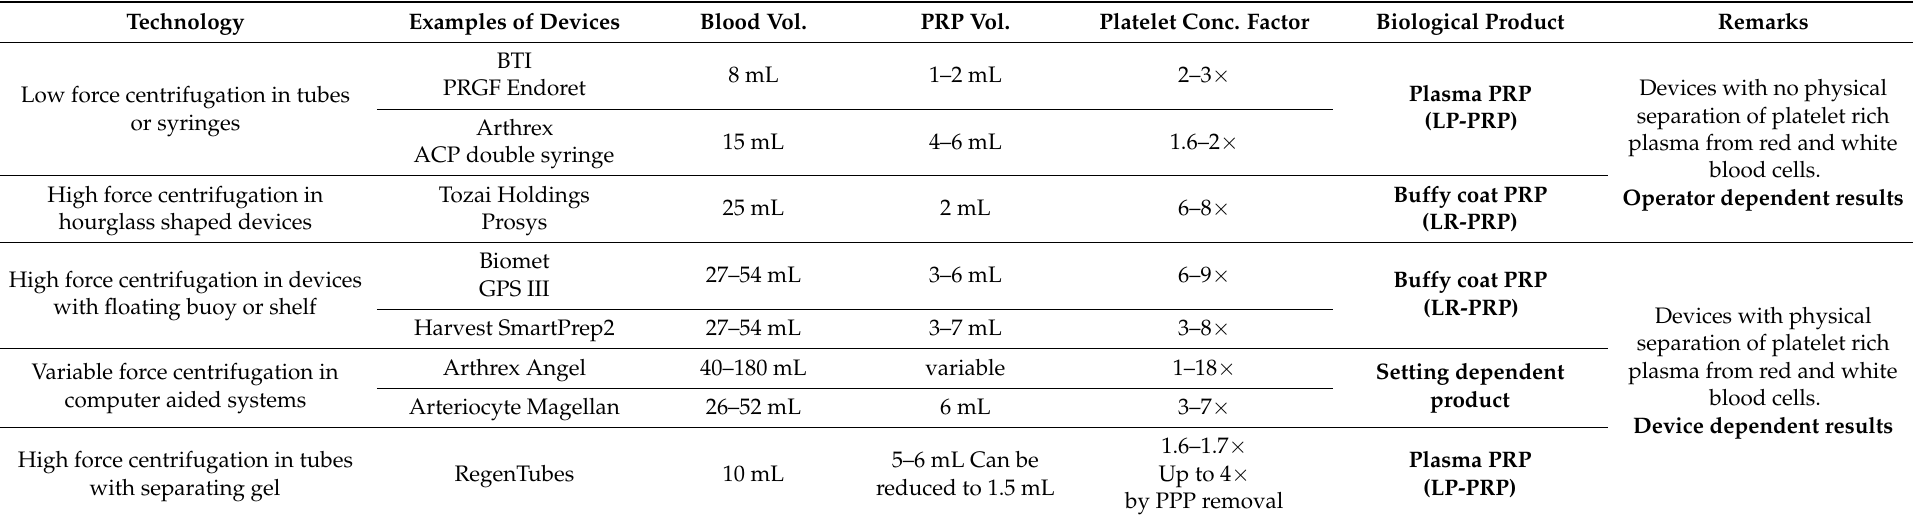
Table 1. Examples of medical devices for PRP preparation. Blood Vol.: Volume of blood PRP vol.: Volume of PRP; Platelet conc. factor: Platelet concentration